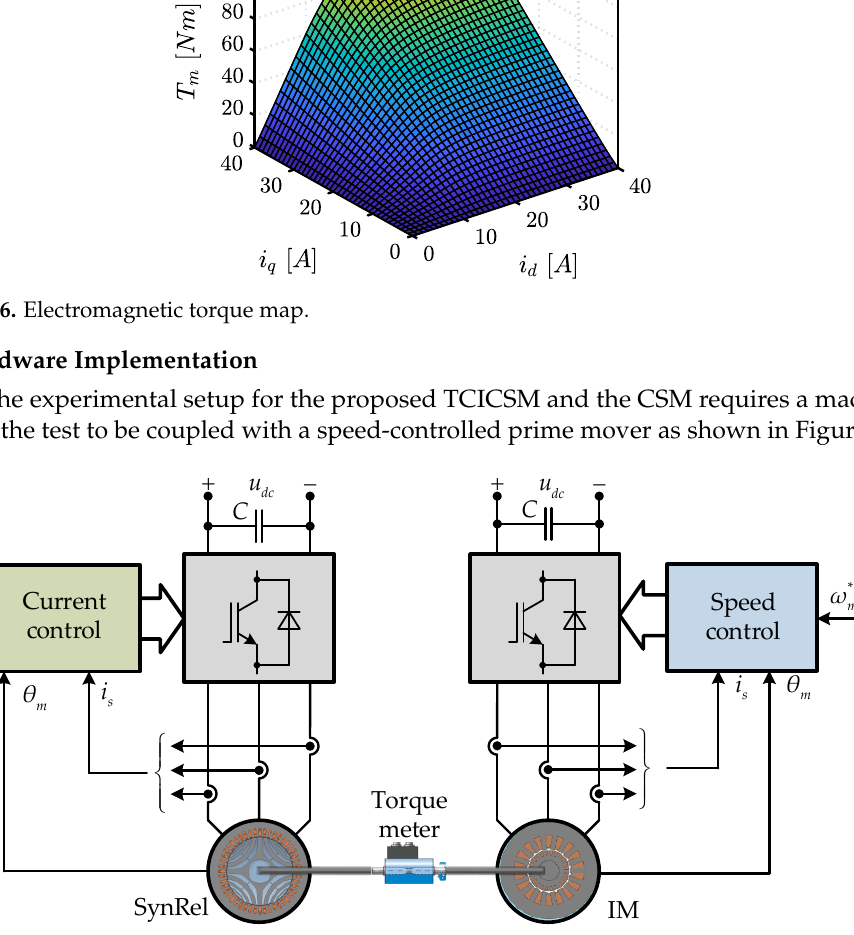
Figure 7. Block scheme of magnetic model identification